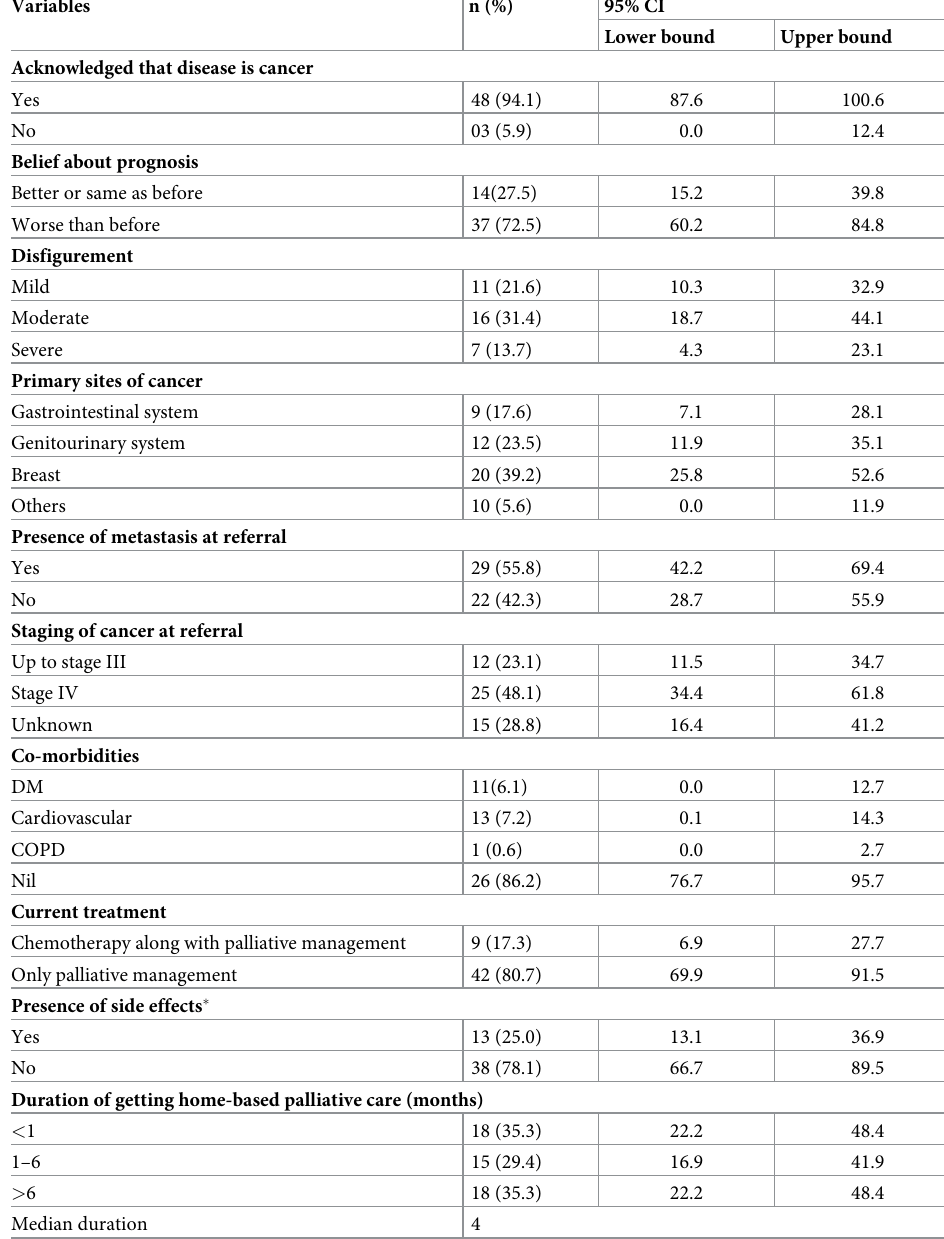
Table 2. Disease and treatment related factors (n =